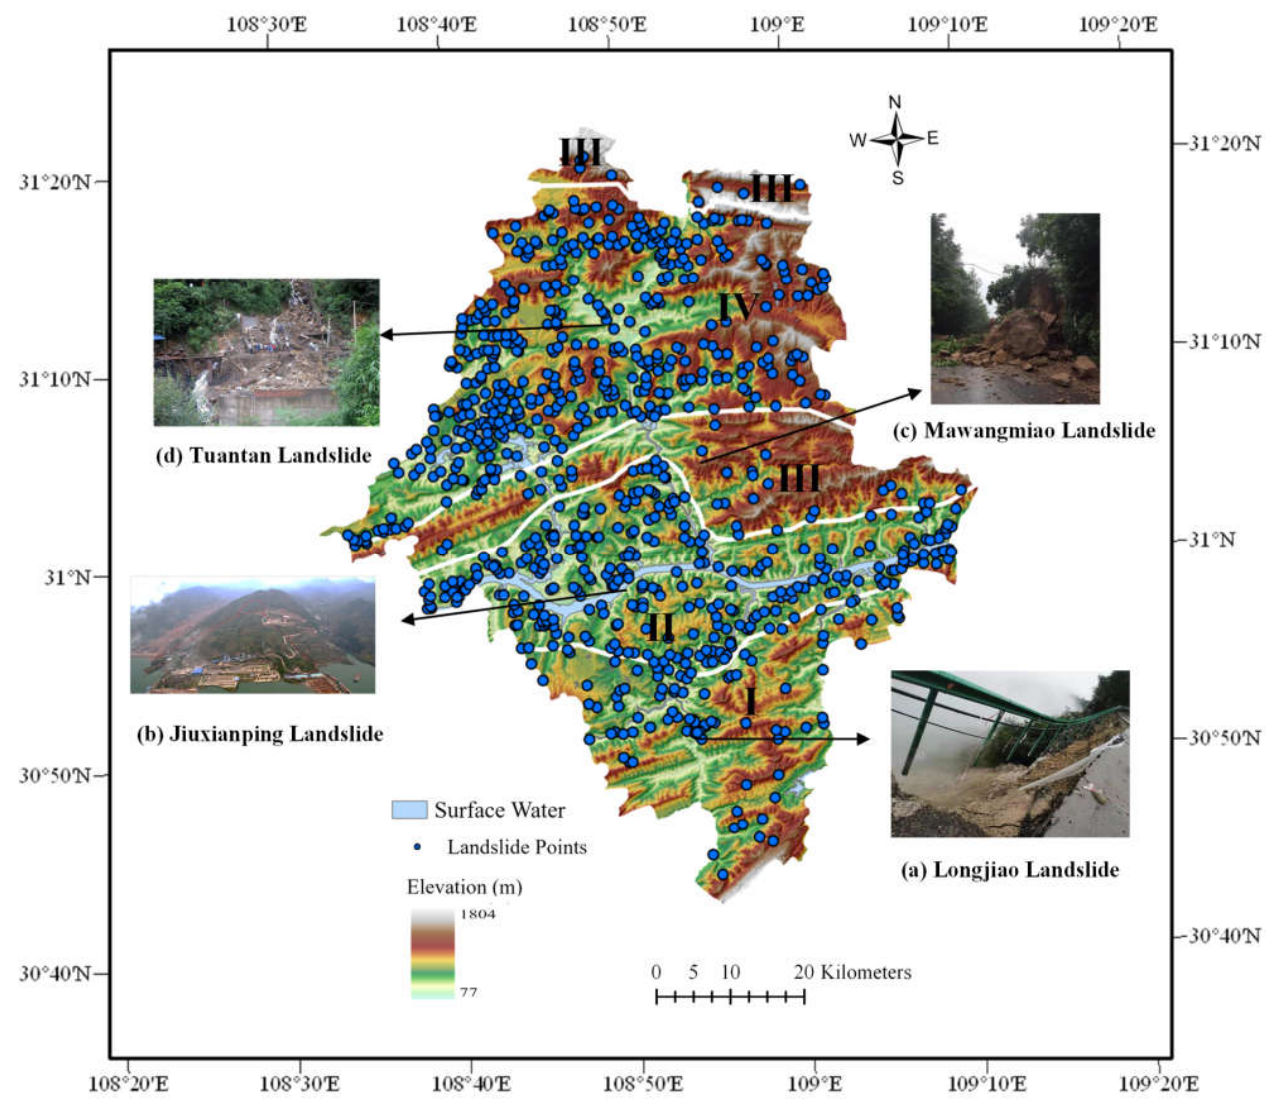
Figure 2. Zonation and typical landslides: ( a ) Longjiao Landslide, ( b ) Jiuxianping Landslide, ( c ) Mawangmiao Landslide, ( d ) Tuantan Landslide